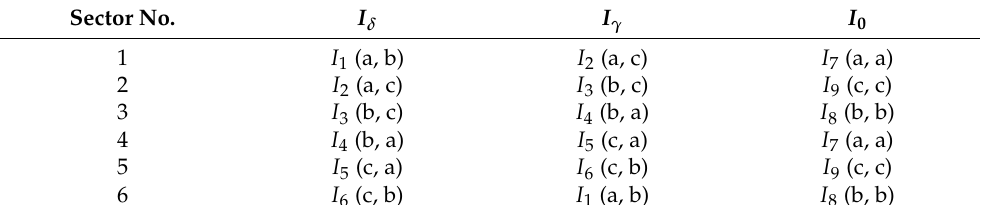
Table 1. Switching sequence for the rectifier for different sectors to minimize switching losses. Sector No.